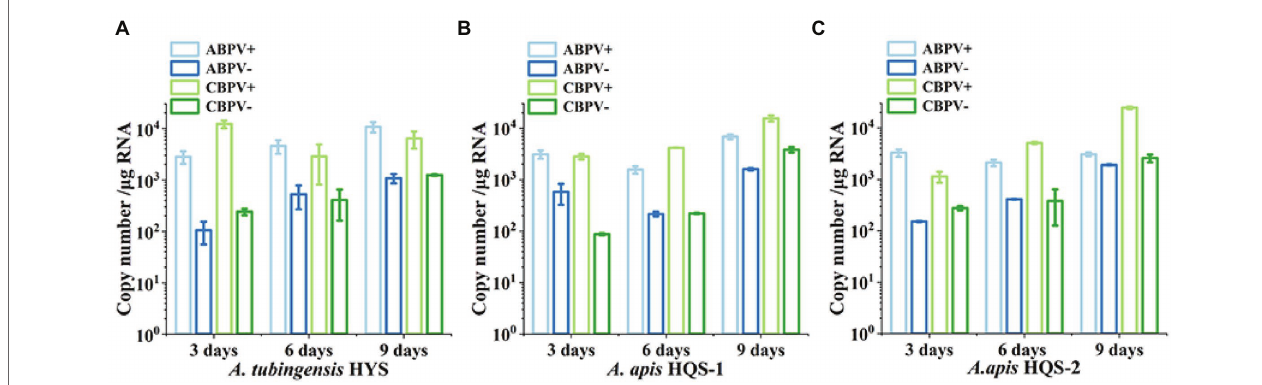
FIGURE 6 | Quantify the positive and negative-strand RNAs of acute bee paralysis virus (ABPV) and chronic bee paralysis virus (CBPV) in Aspergillus tubingensis and Aspergillus apis at different culture times. Copy number of positive and negative-strand RNAs of ABPV and CBPV in A. tubingensis (A) . Copy number of positive and negative-strand RNAs of ABPV and CBPV in A. apis HQS-1 and HQS-2, respectively (B,C)